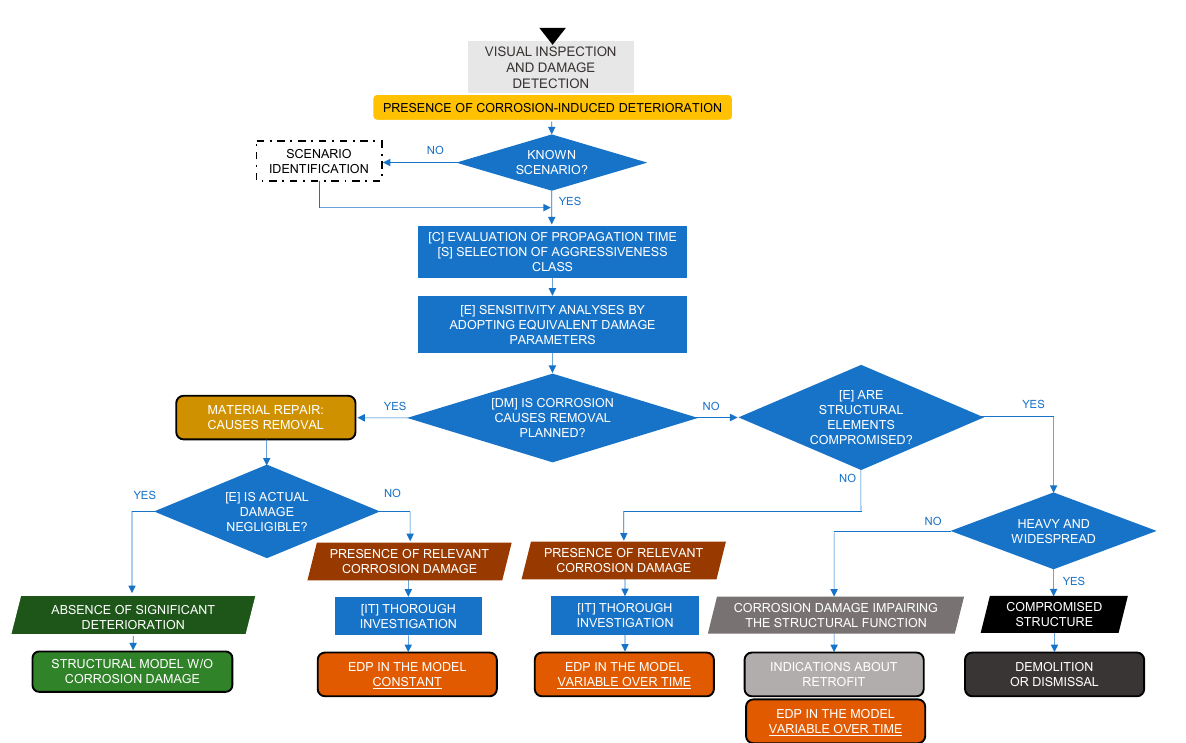
Figure 8. Flow chart to be followed in the case of ‘presence of corrosion-induced deterioration’. Type of operations required: (C)—calculations, (S)—surveys, (E2)—quantitative evaluations, (DM)—decision making processes, (IT)—instrumental tests.